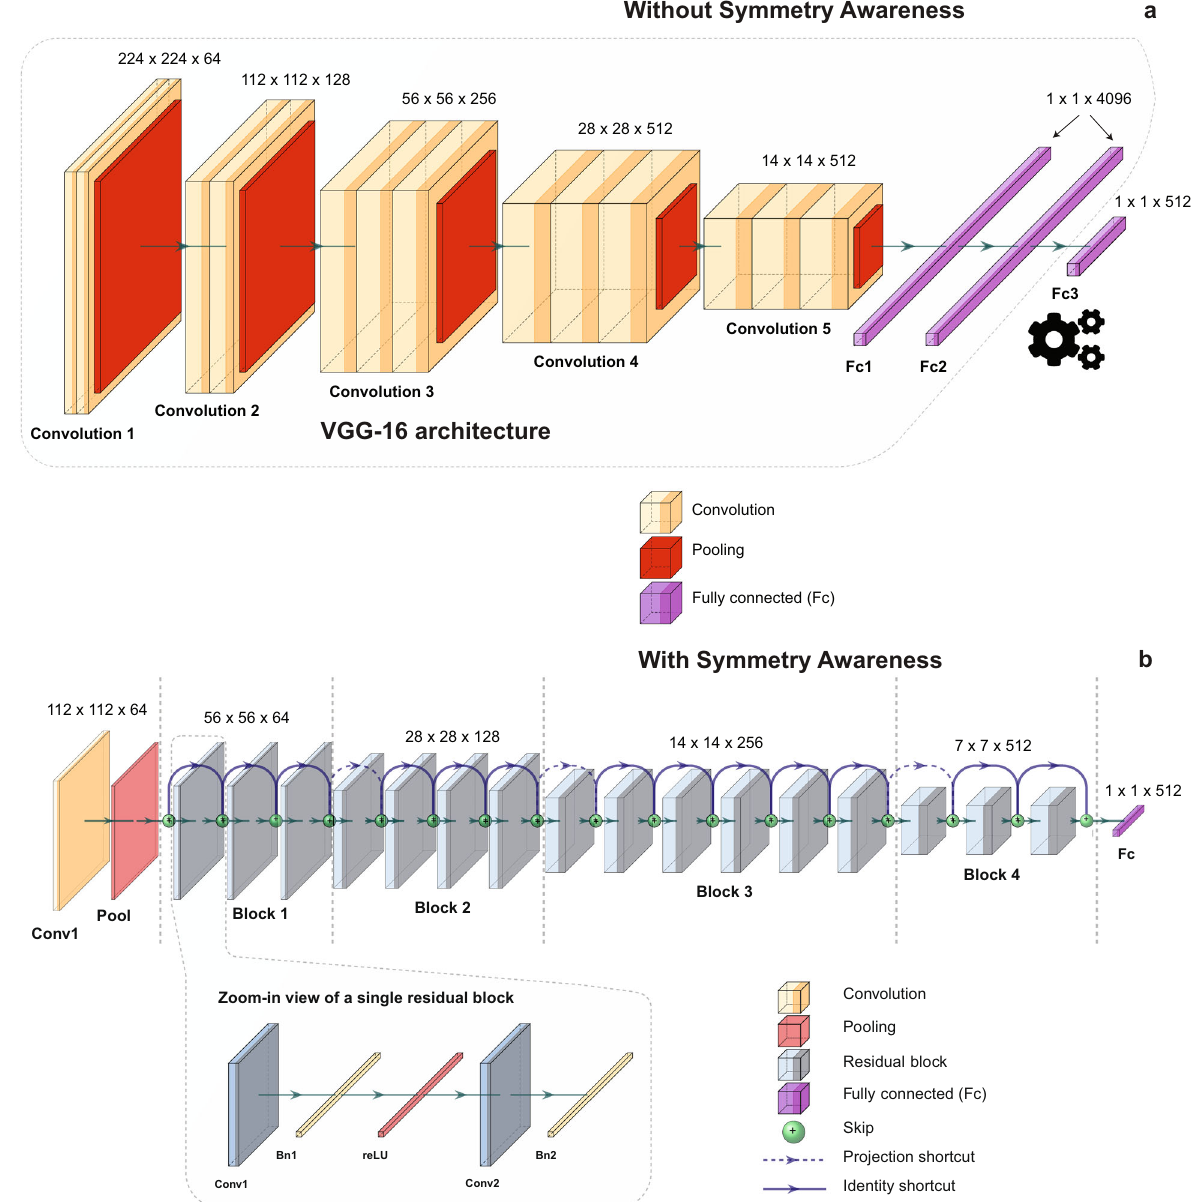
Fig. 1 Schematic illustration of image similarity computational structure. a VGG-16 architecture pretrained on ImageNet database. The gray area represents the pretrained VGG-16 model. FC3 was determined by training an autoencoder to reduce the dimensionality of the feature vector from 4096 to 512. The gear represents that this is the only layer optimized in the VGG-16 model. b ResNet-34 architecture with symmetry awareness by training it to classify wallpaper group